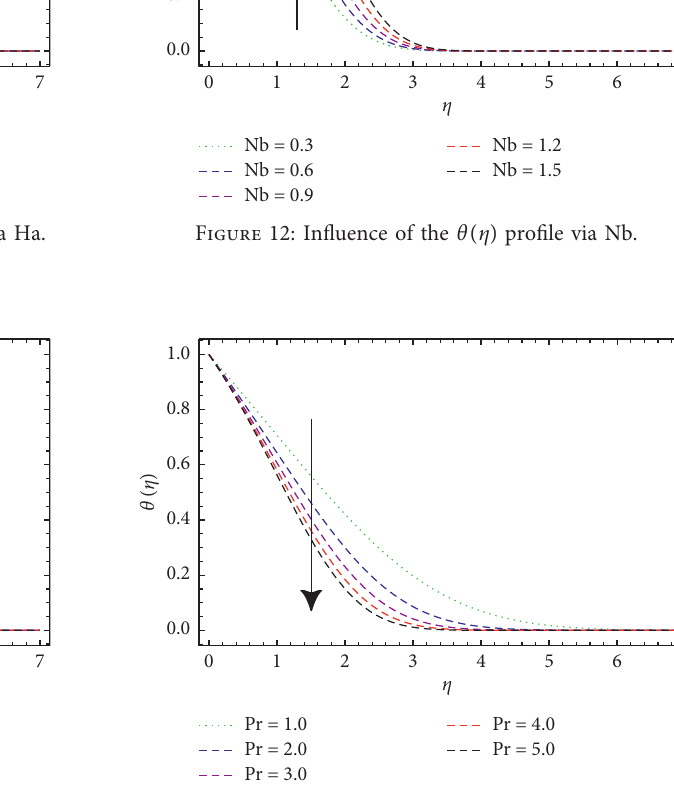
Figure 10: Influence of the temperature θ ( η ) profile via R .